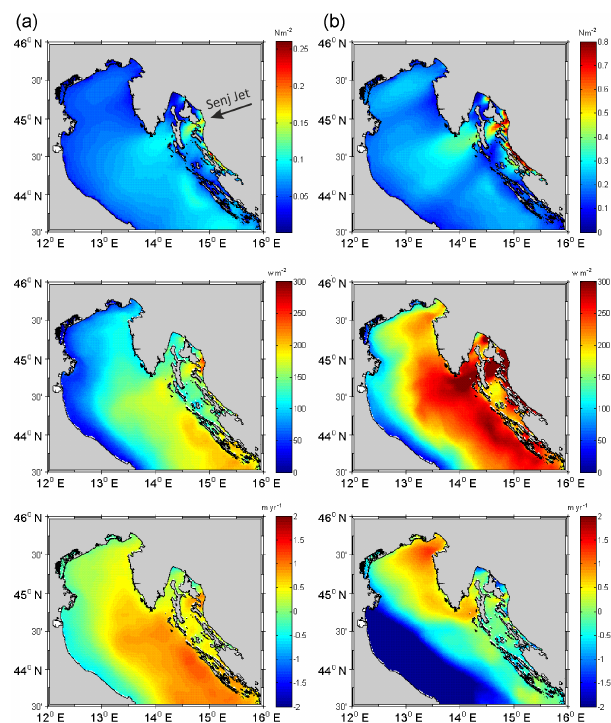
Figure 2. Wind stress module (top), net heat flux (middle) and water ( E − P ) flux (bottom) in the middle and northern Adriatic averaged (a) between 15 January and 15 March 2015 and (b) over all bora episodes occurring between 15 January and 15 March 2015. Bora episodes are defined by a wind speed higher than 15ms − 1 blowing along the major wind axis (from ENE) at the G1